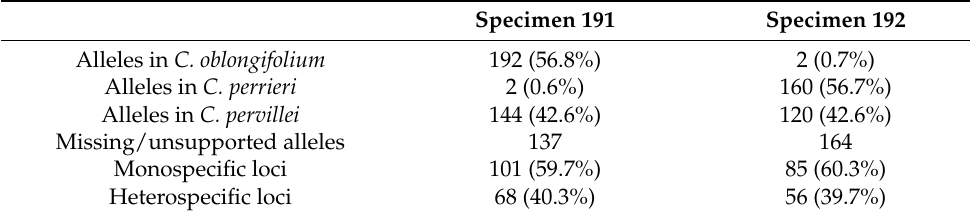
Table 4. Topological positions of the alleles of specimens 191 (Randrianarivelo 307) and 192 (Ran- drianaivo 953) based on 305 maximum likelihood trees from protein coding genes. Monospecific loci refer to loci in which both alleles appeared nested in a single species, while heterospecific loci point to exons with each allele nesting within distinct species. Percentages are calculated after having discarded any missing or unsupported